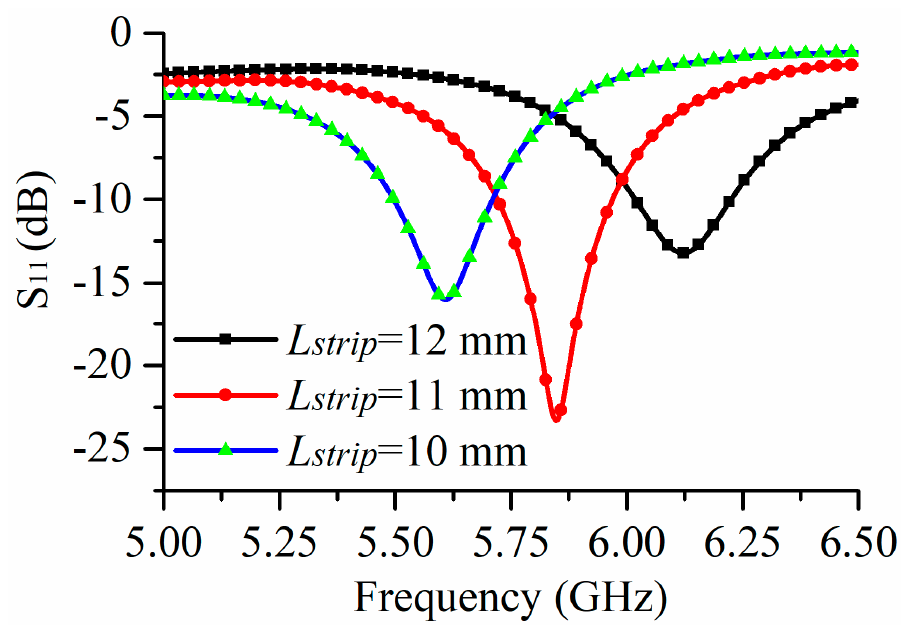
Figure 4. Simulation S 11 under different values of L strip .